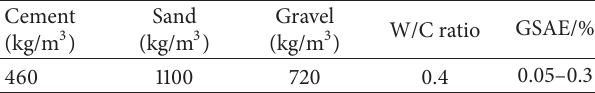
Table 2: Mix proportion of wet-mix shotcrete with GSAE.